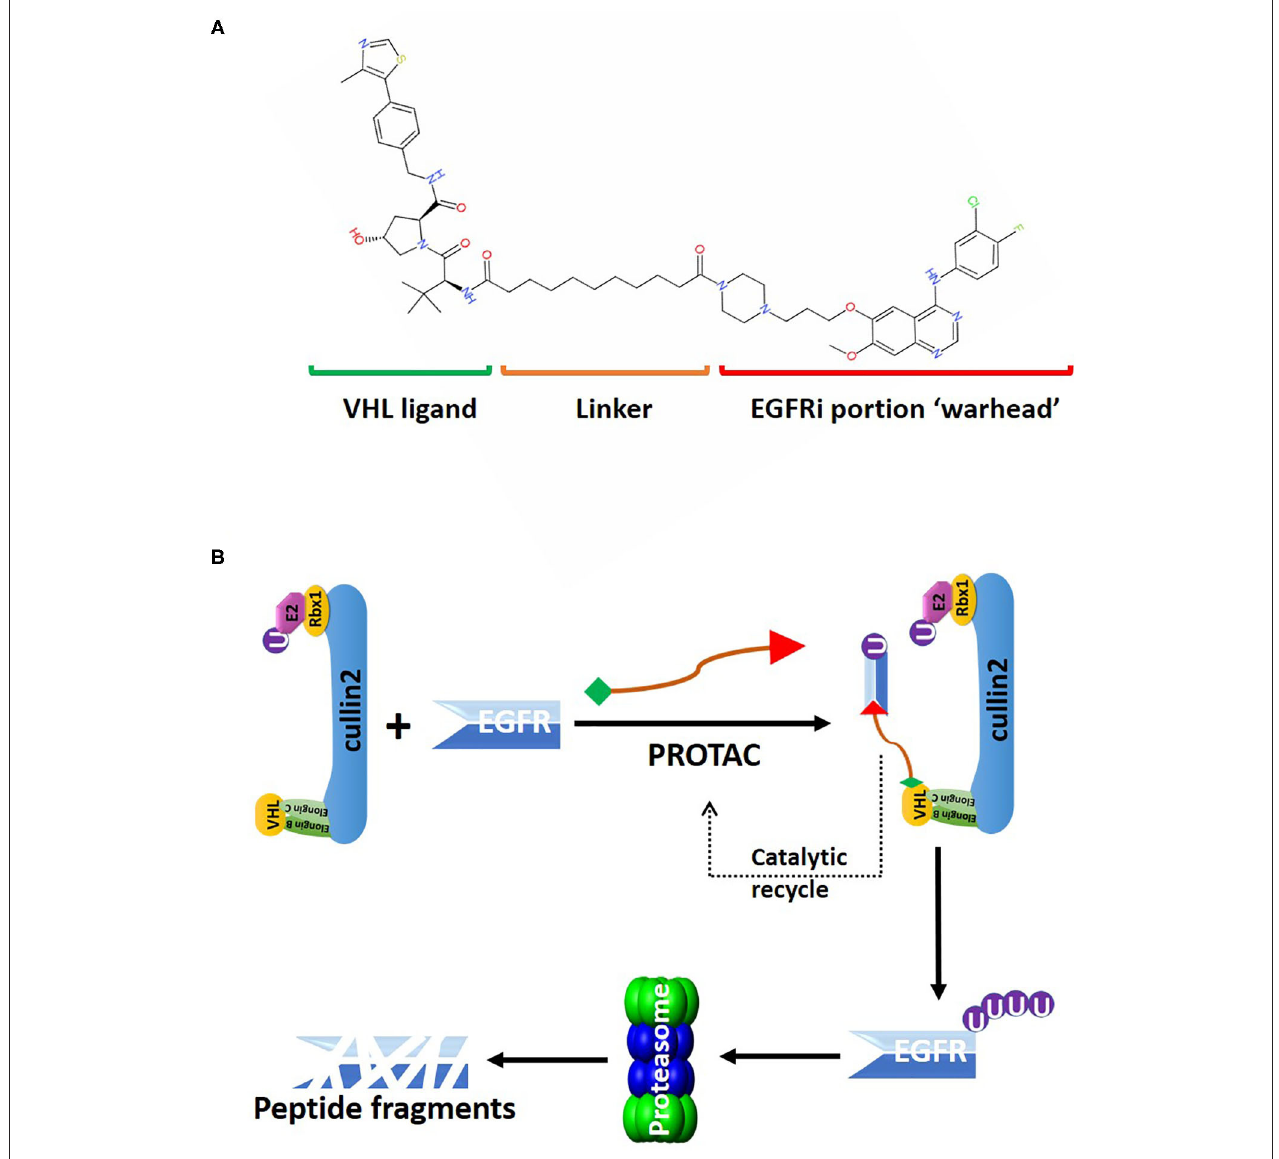
FIGURE 3 | An overview of the PROTAC targeting EGFR for CRL2 VHL -mediated polyubiquitination. (A) 2D structure of the PROTAC MS39 that targets EGFR. The “warhead” potion of the PROTAC is based on EGFR inhibitor (EGFRi) gefitinib. (B) MS39 can recruit EGFR for polyubiquitin conjugation by the CRL2 VHL . MS39 mediated EGFR degradation is a catalytic process, as evidenced with dissociation of the PROTAC from the CRL2 VHL complex after EGFR